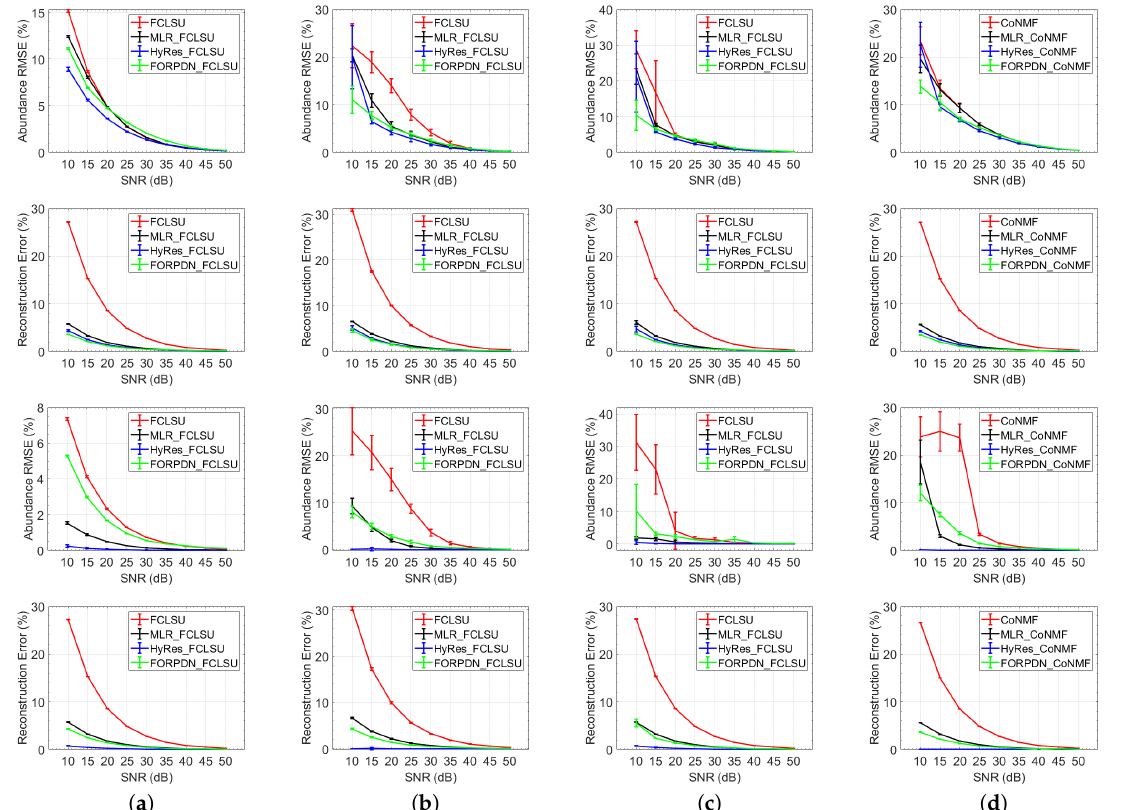
Figure 5. Simulated data (top two rows η = ∞ and bottom two rows η = 18): The results of unmixing in terms of abundance RMSE and reconstruction error as a function of the noise level of the observed image (in SNR). ( a ) Ground truth endmembers; ( b ) extracted endmembers; ( c ) library endmembers; ( d ) estimated endmembers. FCLSU, fully constrained least squares unmixing; FORPDN, first order spectral roughness penalty denoising; CoNMF, collaborative nonnegative matrix factorization; HyRes, hyperspectral